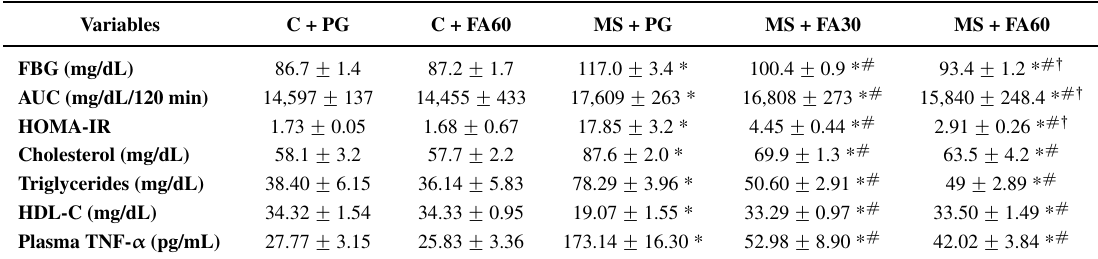
Table 3. Effect of FA on metabolic variables and inflammatory